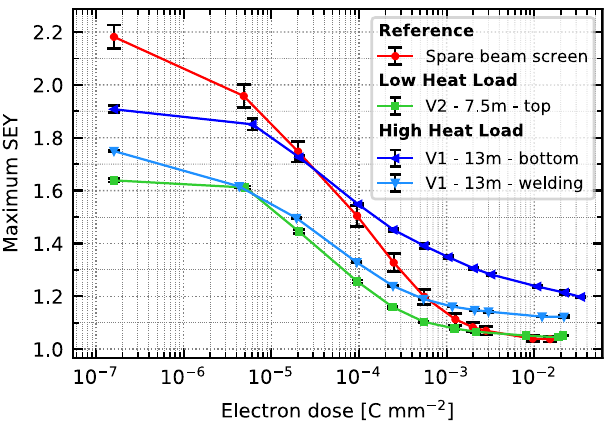
Fig. 7 Conditioning curves. Electron-irradiation-induced variation of the maximum secondary electron yield (SEY) of the bottom (dark blue) and welding (cyan) sides of a beam screen section from the High Heat Load dipole and of the top side of a beam screen section from the Low Heat Load dipole (green), all located in the fi eld region of their respective magnet. The conditioning curve of a reference spare beam screen is given in red for comparison. The error bars represent the statistical measurement uncertainties for a con fi dence level of 68.3% based on three measurements performed in different locations of the